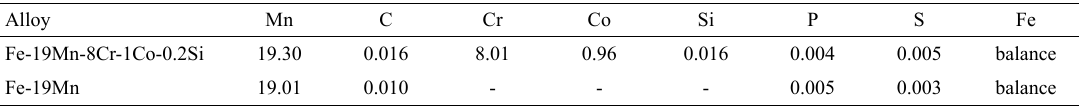
Table 1. Chemical compositions of the two alloys,